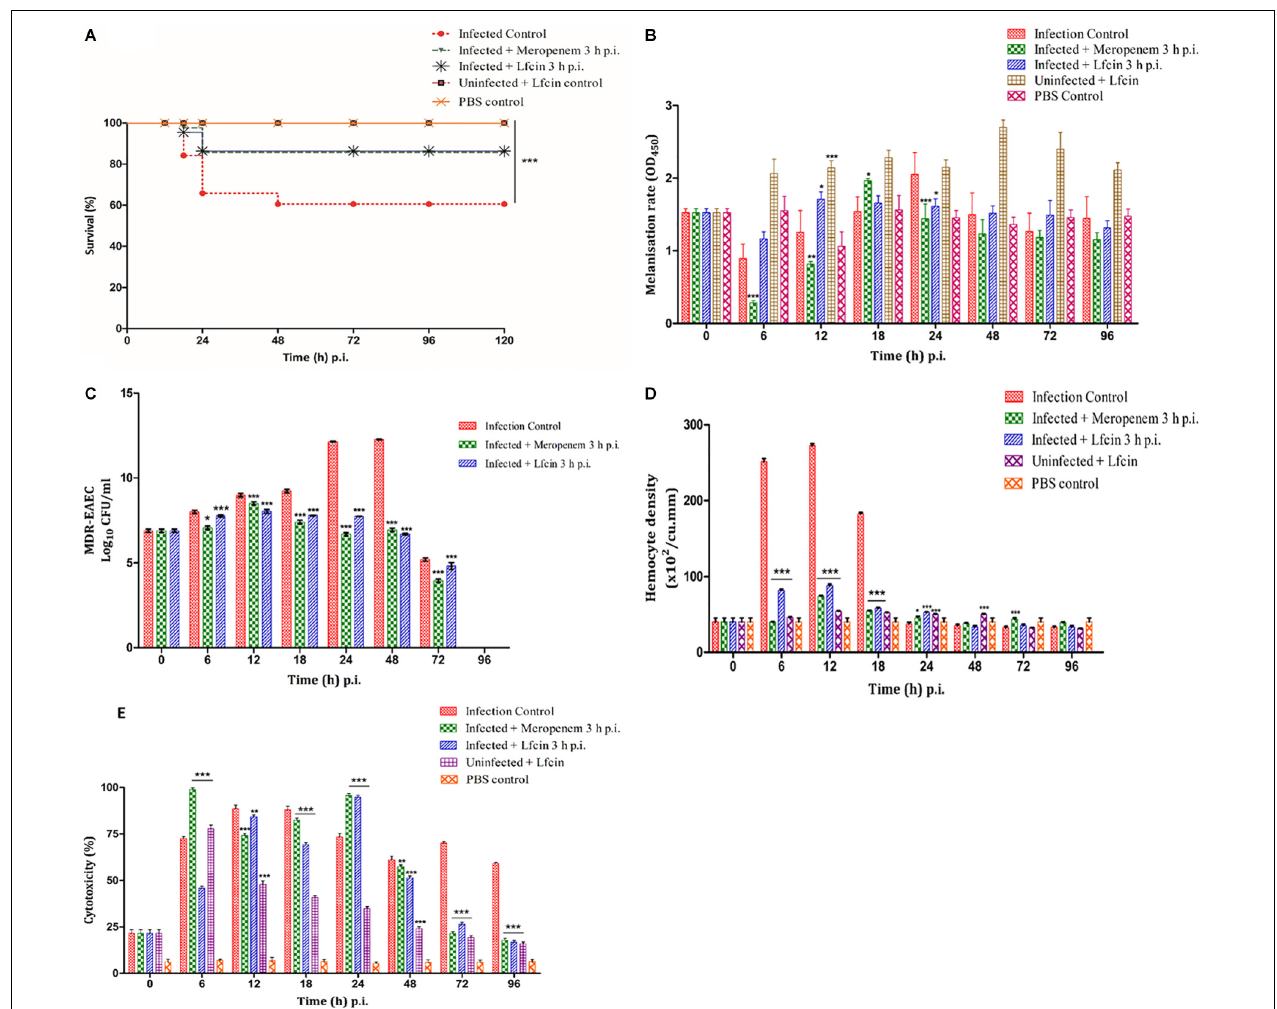
FIGURE 3 | In vivo assays using G. mellonella model. Survival plot (A) , melanization rate (B) , MDR-EAEC counts (C) , hemocyte density (D) , and LDH cytotoxicity assay (E) of G. mellonella larvae infected with LD 50 dose (10 6 CFU) of MDR-EAEC strains and treated with MIC (1 × ) of Lfcin (17–30) 3 h pi. MDR-EAEC-induced infection was treated with MIC of Lfcin (17–30), keeping respective controls [infection control, meropenem treatment, Lfcin (17–30) control, PBS control]. Data expressed as the mean ± standard deviation of three independent experiments (* P < 0.05; ** P < 0.01; *** P < 0.001). Melanization rate was assessed by absorbance monitored at 450 nm, MDR-EAEC counts as log 10 CFU/ml of hemolymph on EMB agar plates supplemented with ampicillin (100 µ g/plate), hemocyte density as cells/ml of hemolymph, and LDH cytotoxicity assay as the cytotoxicity (%) of larval